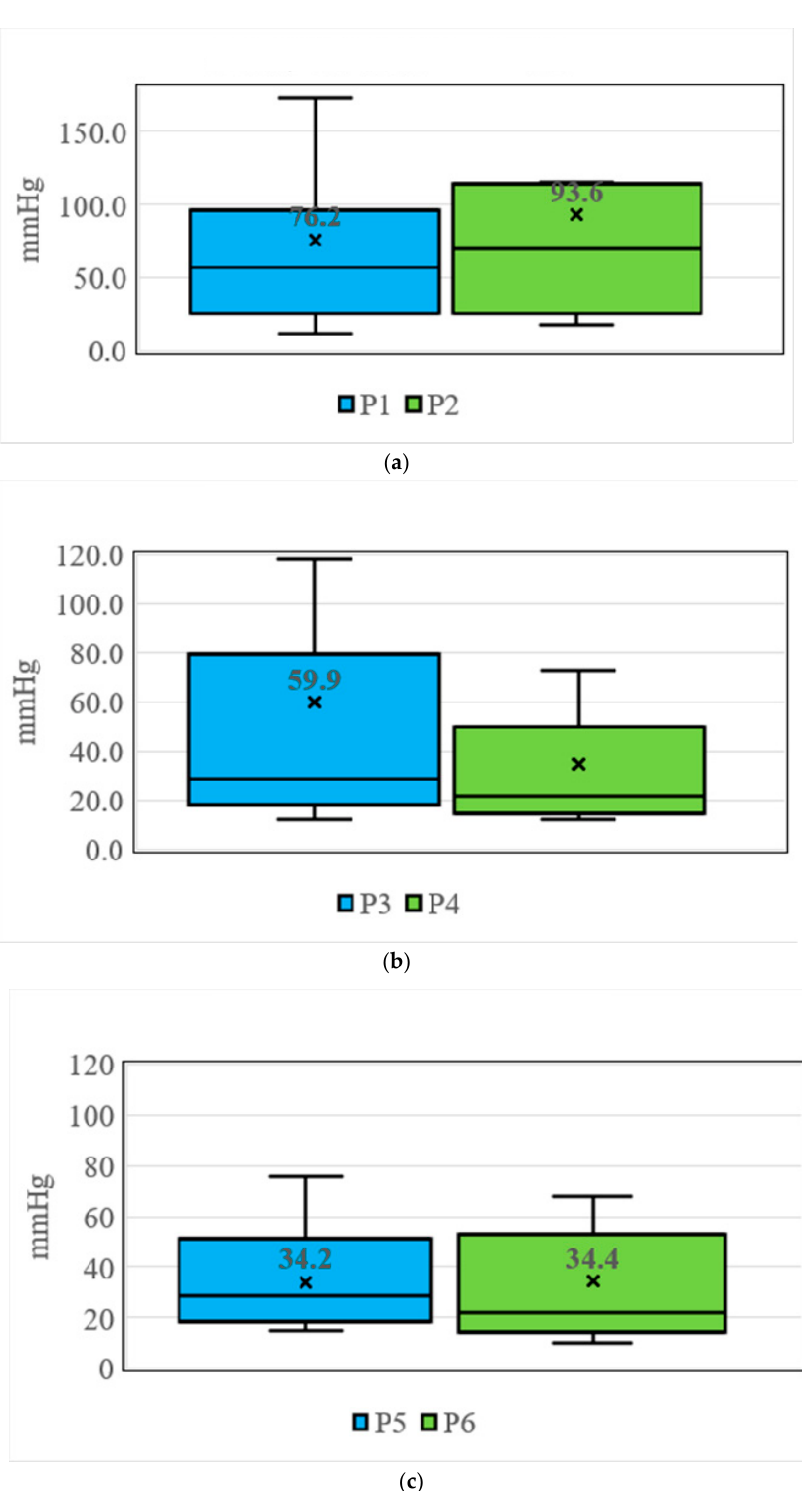
Figure 8. ( a ) Pressures detection over the P1 and P2 sensors. ( b ). Pressures detection over the P3 and P4 sensors. ( c ). Pressures detection over the P5 and P6 sensors.